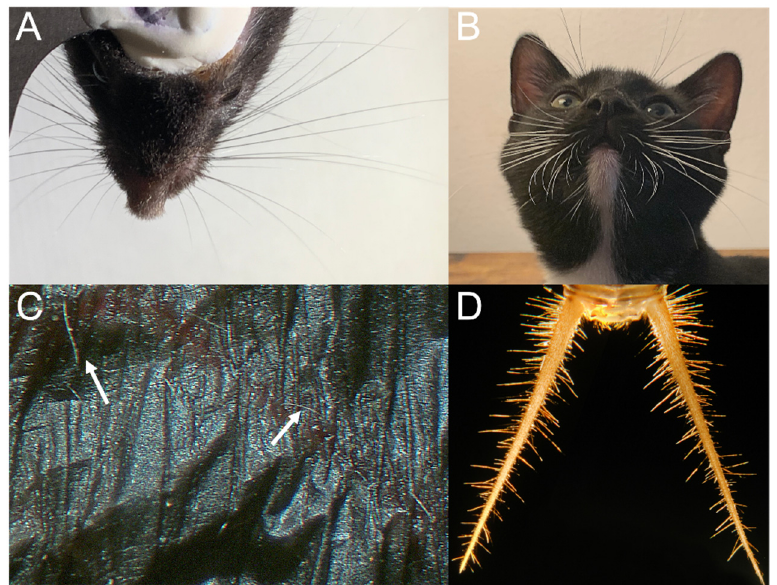
Figure 2. Hairs and hair-like structures aid in coordinated movement, navigation, and exploration. Top row ( A , B ) shows facial vibrissae that aid in orienting and detection. ( A ) Facial whiskers of adult mouse ( Mus musculus , C57b6; photo credit C.A.D.). ( B ) Facial whiskers of juvenile cat ( Felis catus ; photo credit C.A.D.). Bottom row ( C , D ) shows sensory hairs that aid in airflow detection and flight control. ( C ) The wing hairs of an adult male big brown bat ( Eptesicus fuscus ; photo credit C.A.D.). ( D ) The cerci of adult female cricket ( Acheta domesicus ; photo credit [30]).